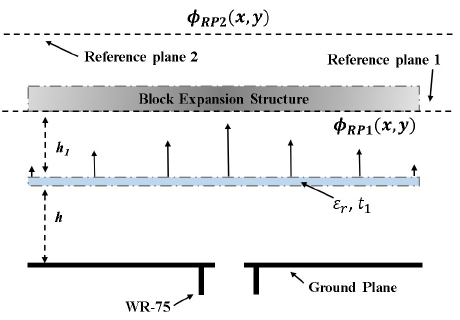
Figure 1. Conceptual model of the proposed resonant cavity antenna (RCA) with the block expansion meta-structure